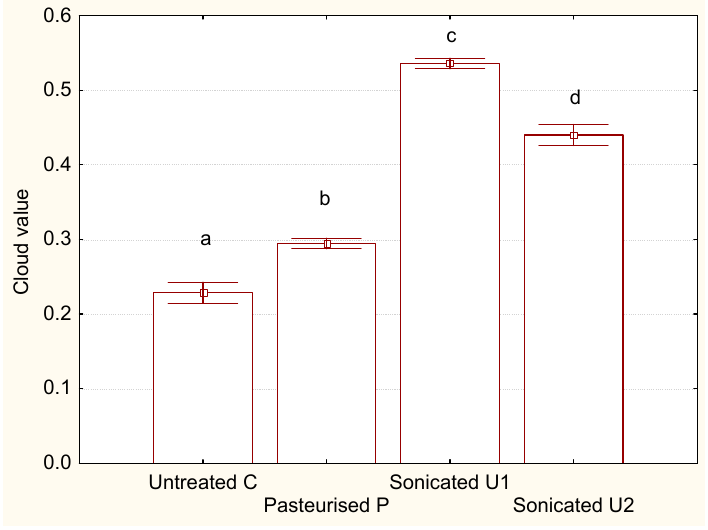
Figure 6. Effect of preservation method on cloud value in apple juice. Error bars represent standard deviations. Values that share the same letter are not significantly different at P < 0.05.